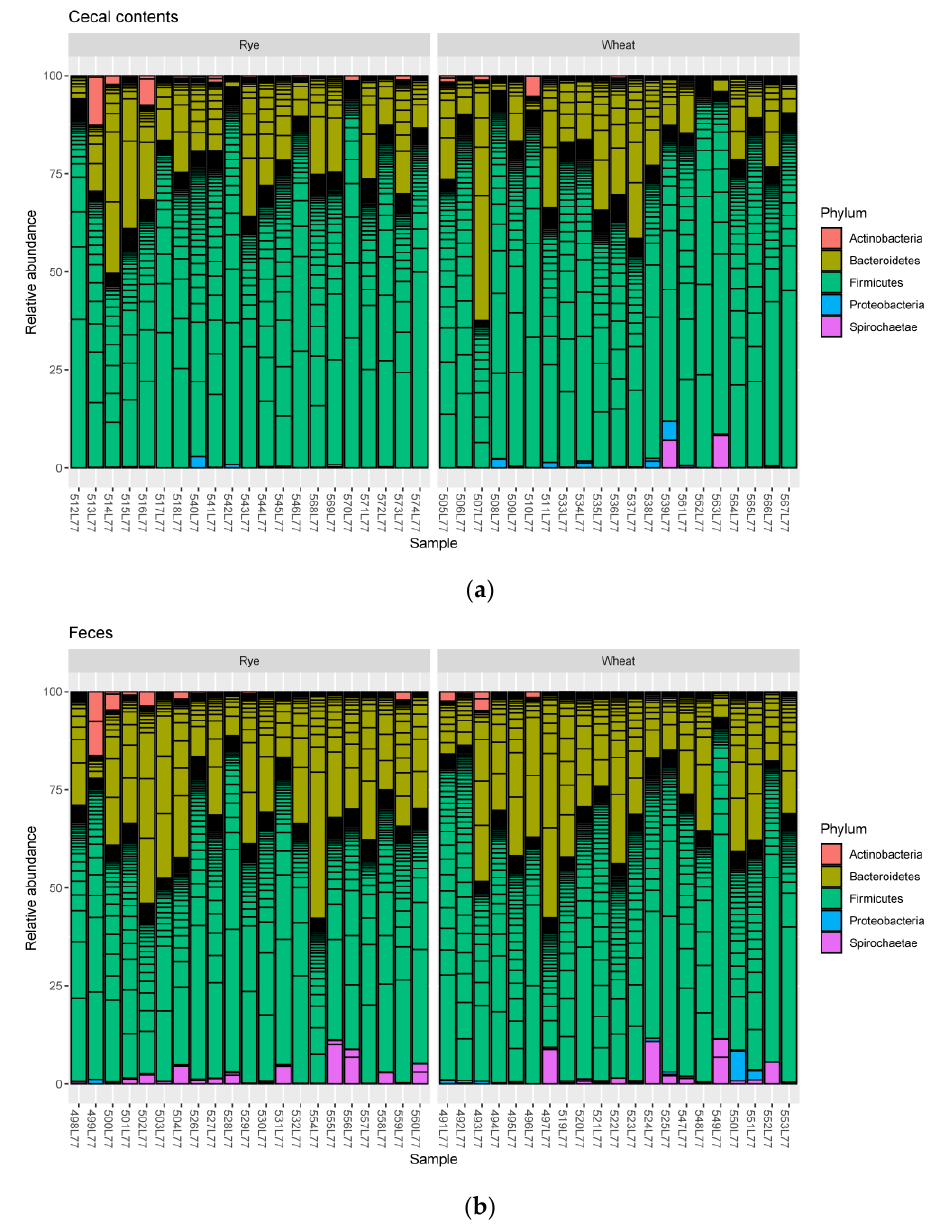
Figure 3. Bar charts represent the relative abundances of the dominant phyla in ( a ) cecal contents and ( b) feces of pigs.